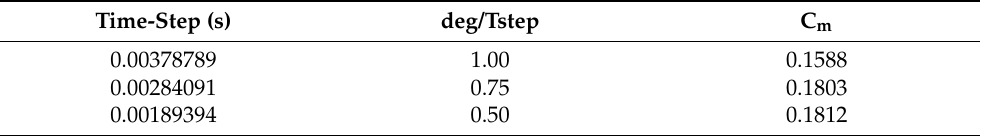
Table 5. Time-step (Tstep) independence data.